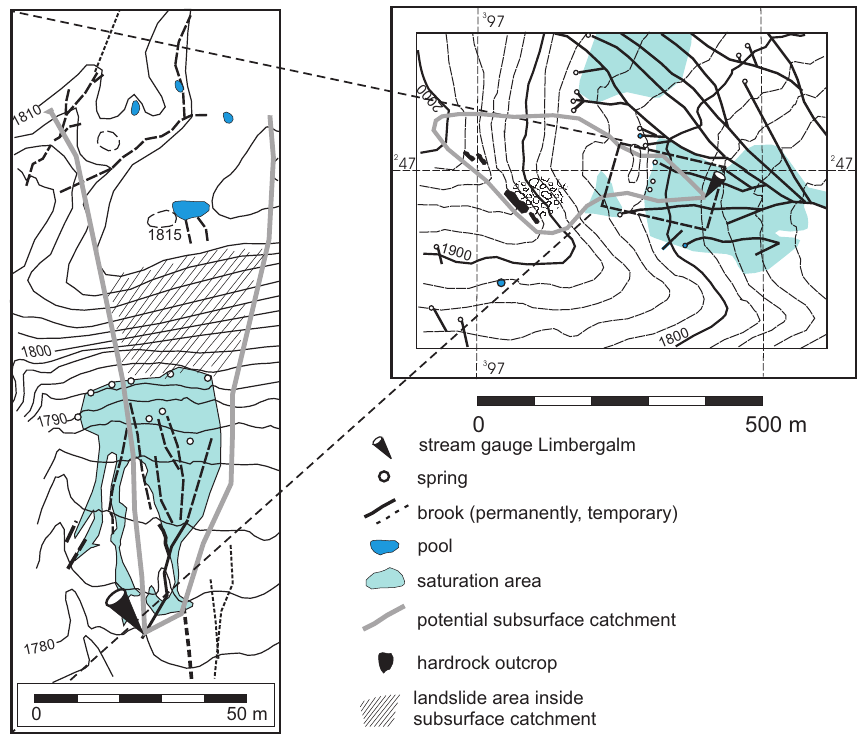
Fig. 3. Headwater catchment Limberg with stream network, saturation areas, ponds and springs (Tilch et al., 2003, modified).